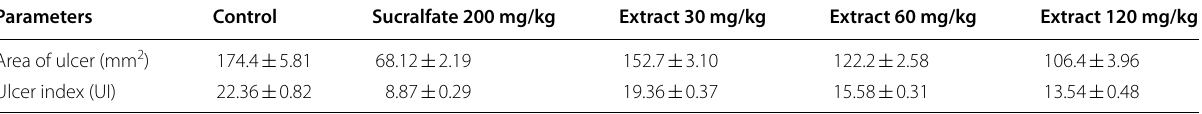
Table 3 Effect of C. zeylanica extract on area of ulcer and ulcer index in ethanol-induced acute ulcers Parameters